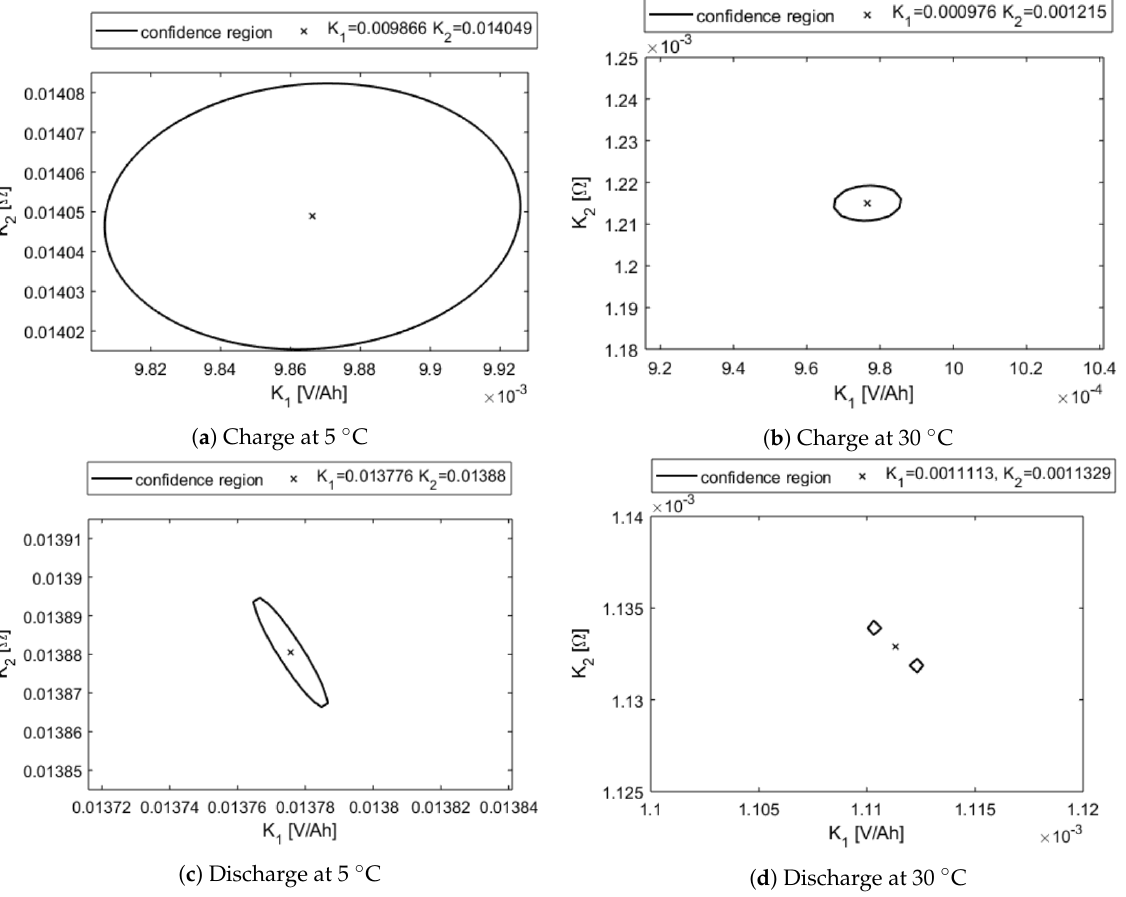
Figure 4. Confidence regions of the estimated parameters K 1 , K 2 during charge/discharge at different temperatures. x axis, K 1 ; y axis, K 2 ; x axis range, 1.25 × 10 − 4 ; y axis range, 7 × 10 − 5 ; − , confidence region; × , estimated parameter